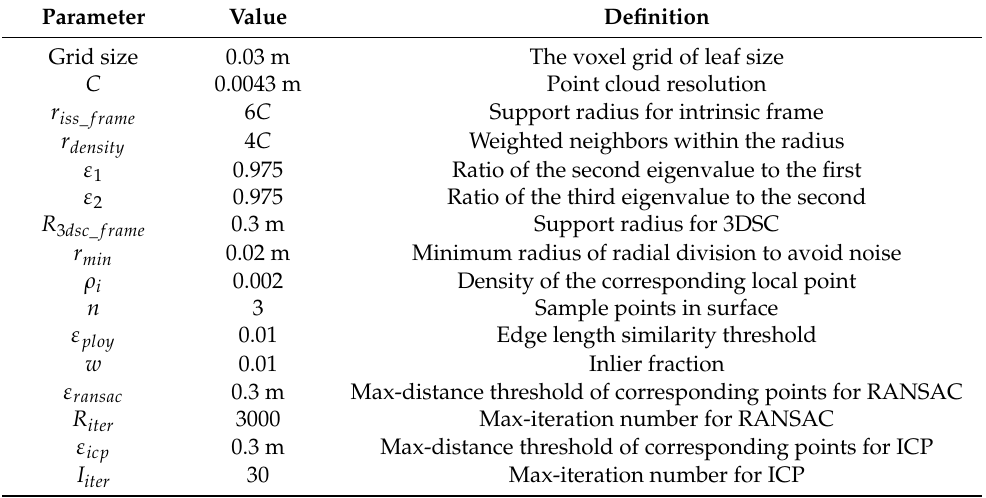
Table 4. Parameters set of this